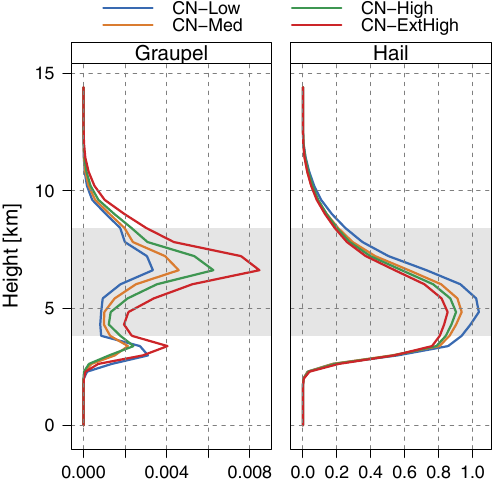
Figure 16. As in Fig. 12, but for graupel and hail mixing